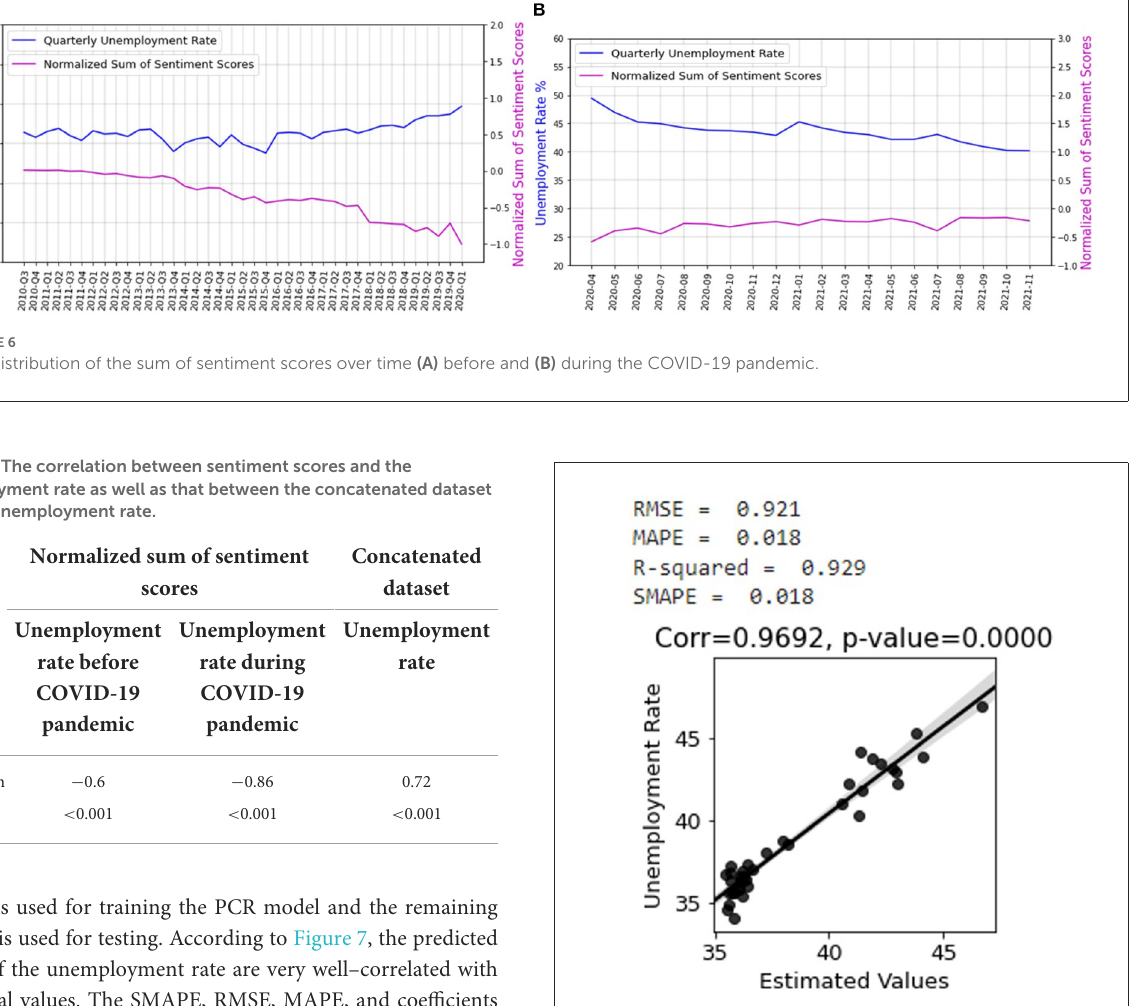
FIGURE7 Correlation between unemployment rate and estimated values of the whole country with 95